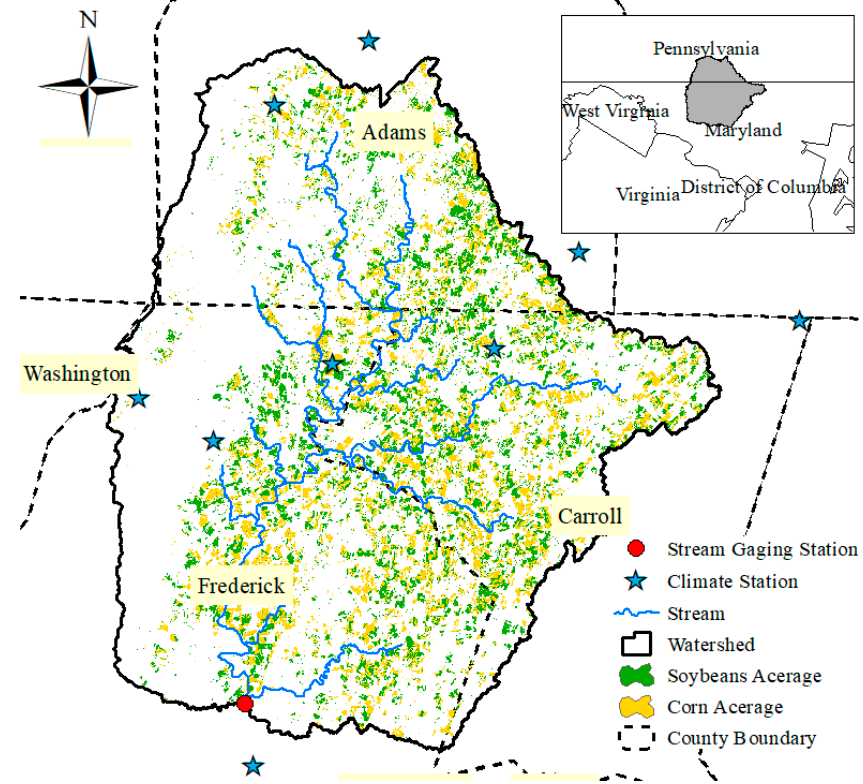
Figure 1. Location of Monocacy River Watershed.